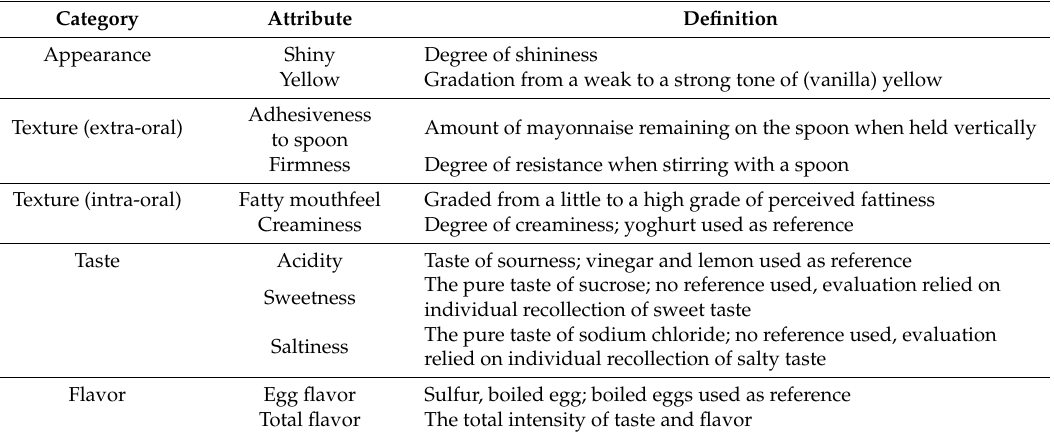
Table 3. Sensory attributes and definitions established by the panel.